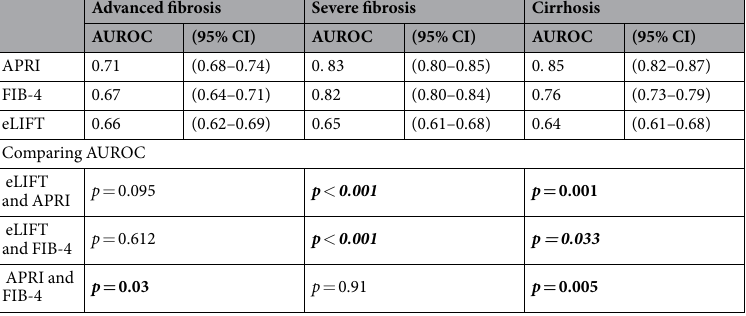
Table 3. Diagnostic performances of noninvasive tests for liver fibrosis and cirrhosis. APRI, aspartate transaminase to platelet ratio index; FIB-4, fibrosis index based on the 4 factors; eLIFT, the easy Liver Fibrosis Test; AUROC, the area under the receiver operating characteristic curve; CI, confidence